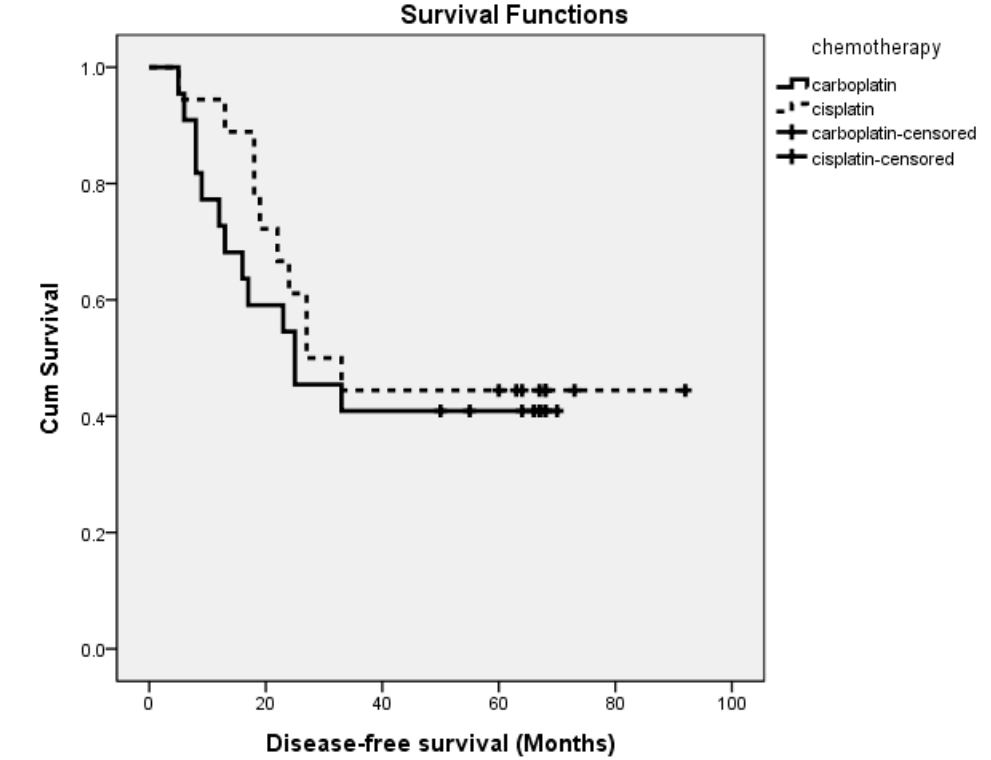
Figure 1. Progression-free survival curves for patients treated either with carboplatin-based dose-dense chemotherapy or with cisplatin-based dose-dense